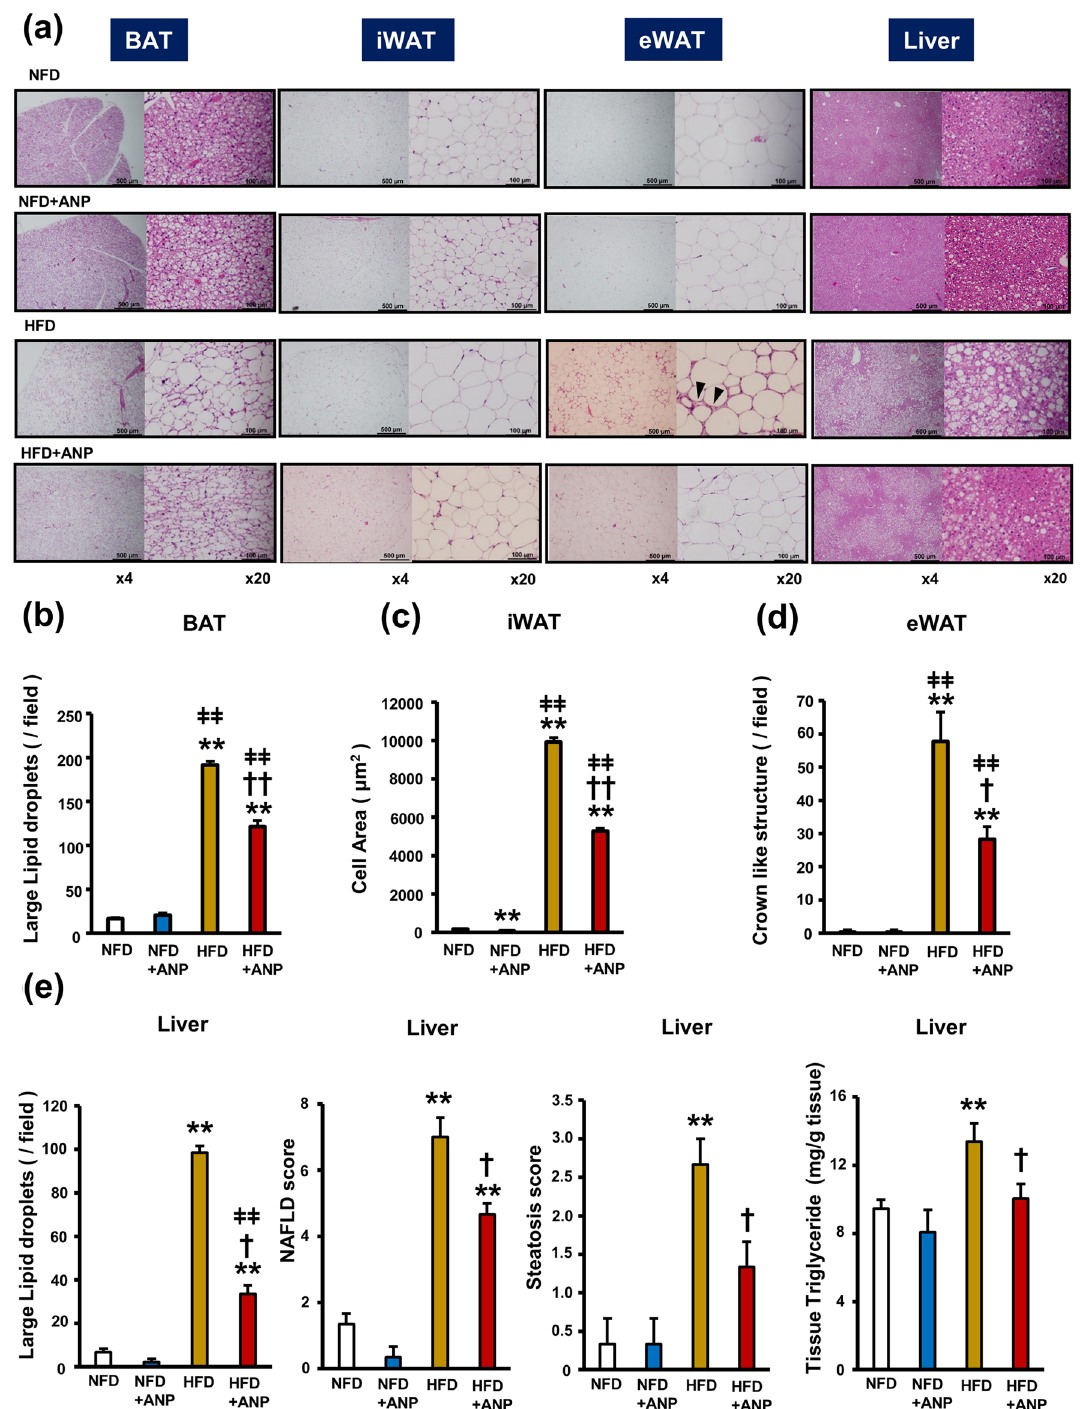
Figure 3. Effects of ANP treatment on HFD-induced enlargement of lipid droplets and inflammation in adipose tissues and hepatic steatosis. ( a ) Representative histological images (hematoxylin–eosin staining) of each tissue harvested from the indicated mice at three weeks after treatment with or without ANP (n = 3 each). The images were captured at a field lens magnification of × 4 (left, bars = 500 μm) and × 20 (right, bars = 100 μm). The arrow heads indicate crown-like structures. ( b ) The number of large lipid droplets (> 100µm 2 )/field in BAT (field lens × 20, n = 3 each). ( c ) The cell area/field in iWAT (field lens × 20, n = 3 each). ( d ) The number of crown like structures/field in eWAT (field lens × 4, n = 3 each). ( e ) The number of large lipid droplets (> 100µm 2 )/ field in liver (field lens × 20, n = 3 each). NAFLD score and steatosis score calculated in each group (n = 3 each). Triglyceride content in the hepatic tissues (n = 5 each). Data are mean ± SEM. * P < 0.05 and ** P < 0.01 versus NFD; † P < 0.05 and †† P < 0.01 versus HFD; ǂ P < 0.05 and ǂǂ P < 0.01 versus NFD +